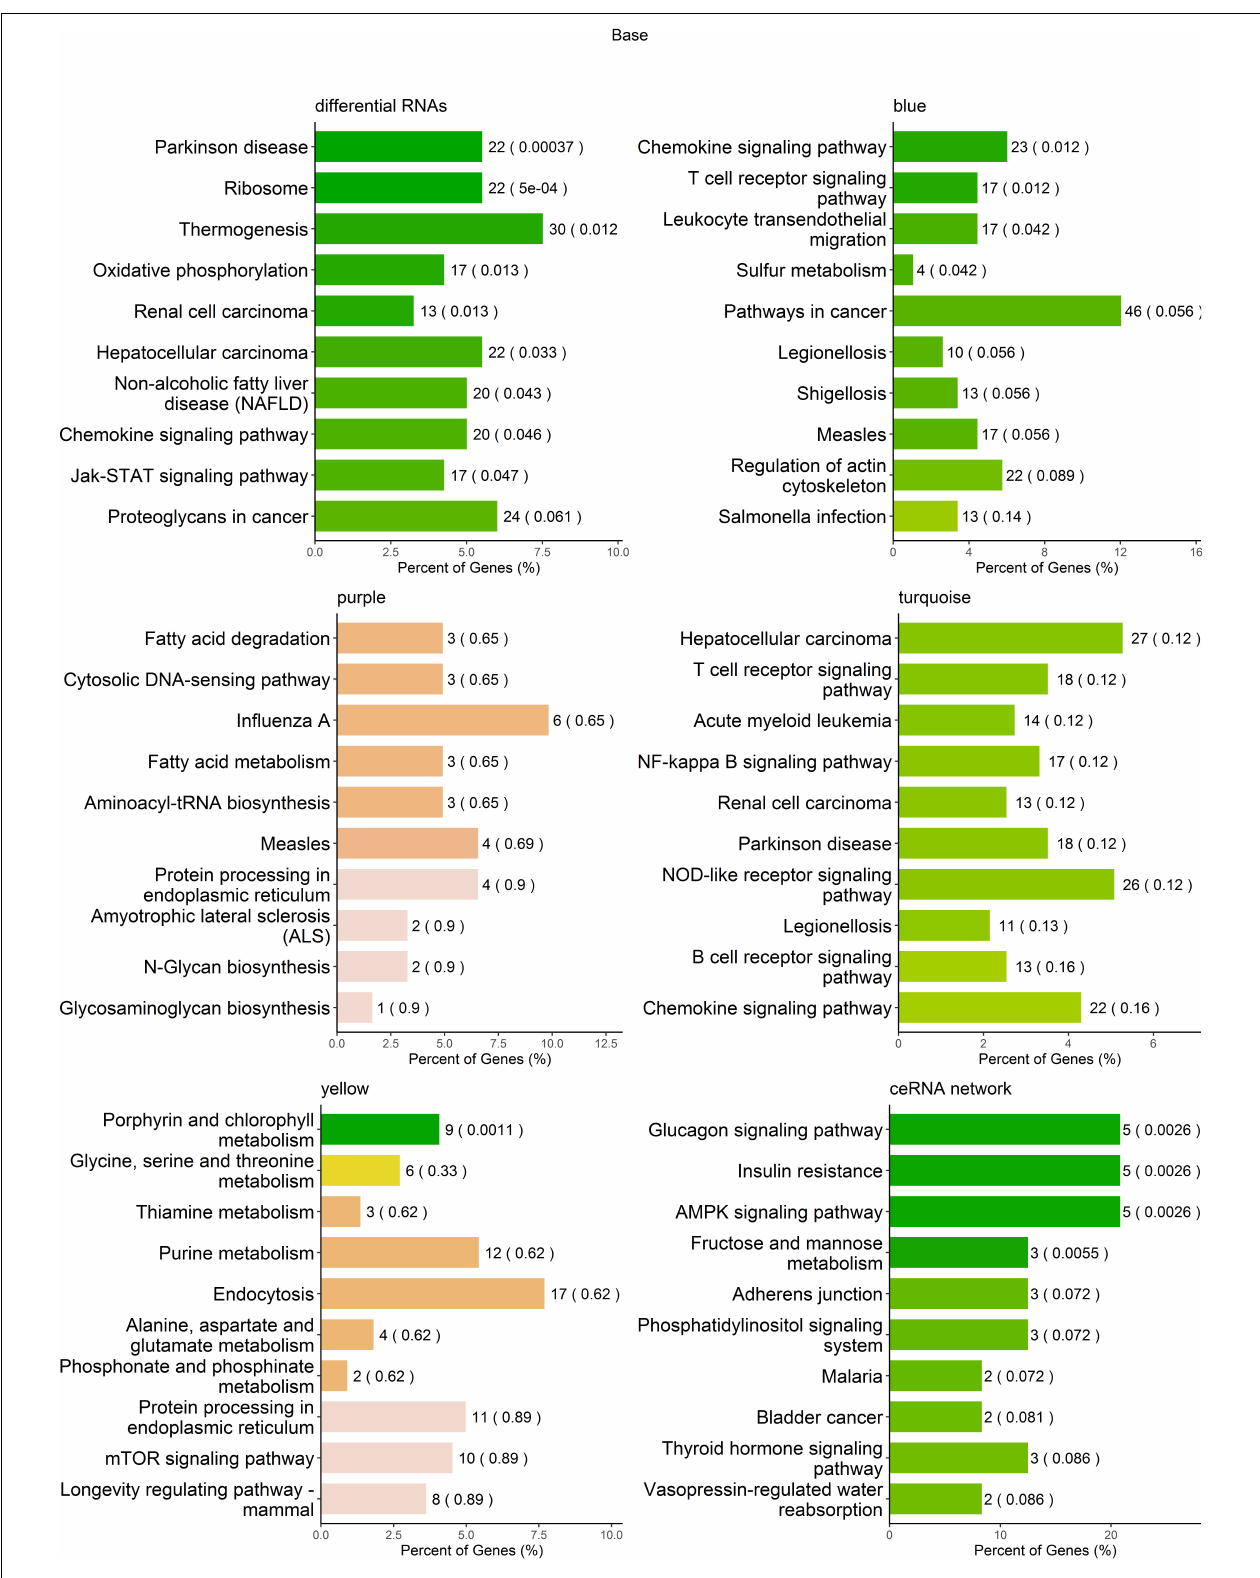
FIGURE 5 | Kyoto Encyclopedia of Genes and Genomes (KEGG) pathway enrichment analysis of RNA transcripts. The top 10 pathways in KEGG pathway enrichment analysis.